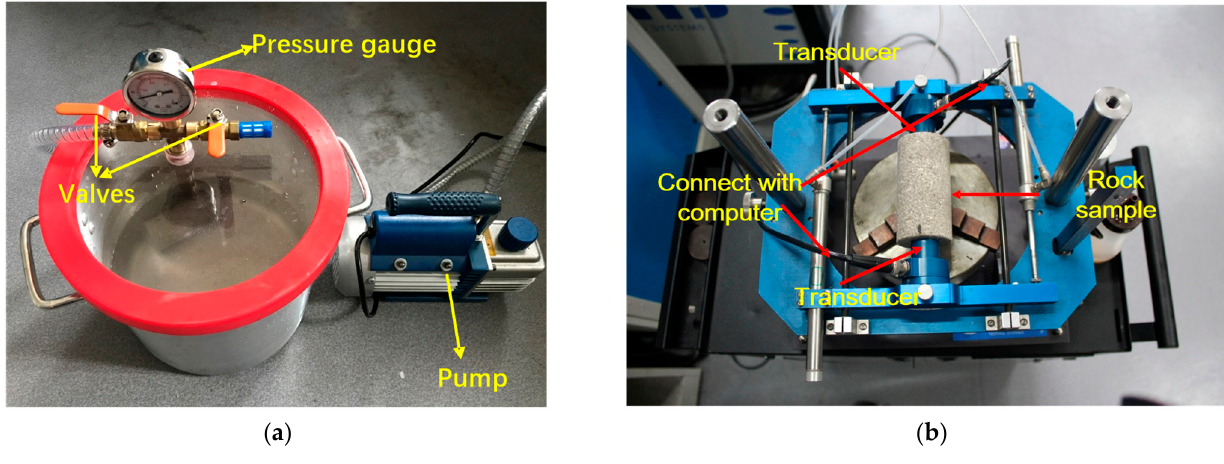
Figure 2. Experimental measurement: ( a ) vacuum device and ( b ) circumferential velocity anisotropy apparatus.